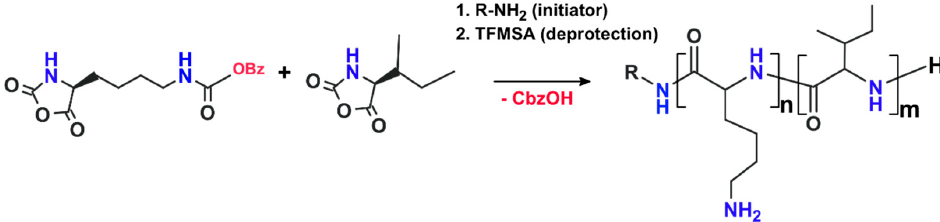
Figure 2. Figure 2. Scheme of the synthesis of P(Lys-co-Ile) via ring-opening polymerization of corresponding NCAs.